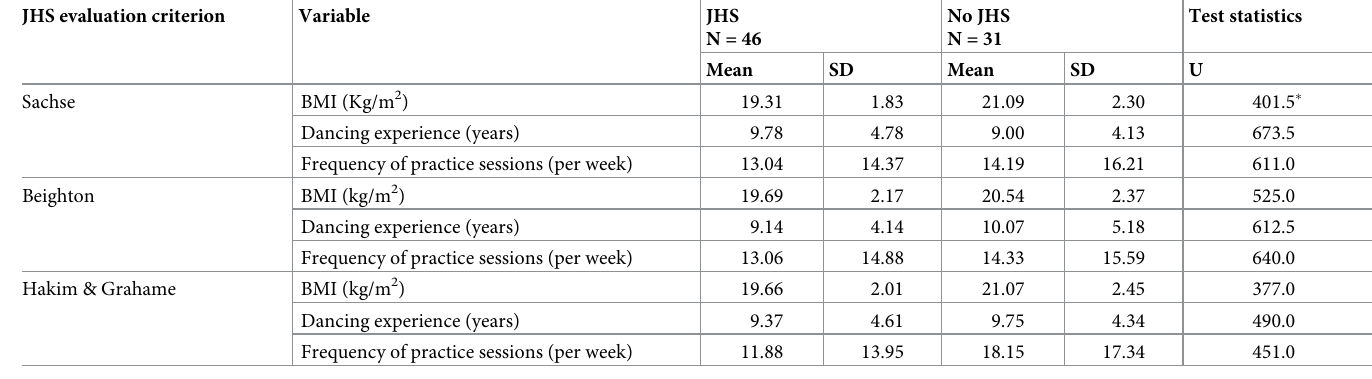
Table 1. Summary of the Mann Whitney U test results, as a comparison of selected variables between JHS patients and healthy individuals, in accordance with dif- ferent evaluation criteria (n = 77). JHS evaluation criterion